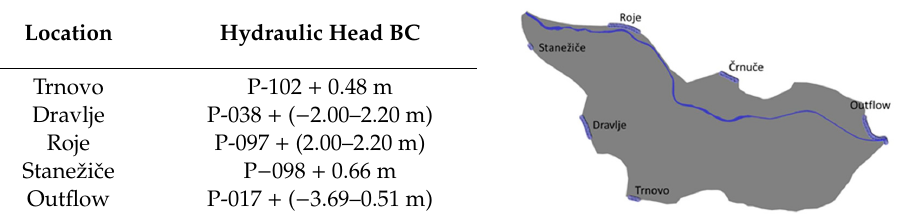
Table 4. Hydraulic head BC set up parameters. Hydraulic head BC in Č rnu č e was later excluded.